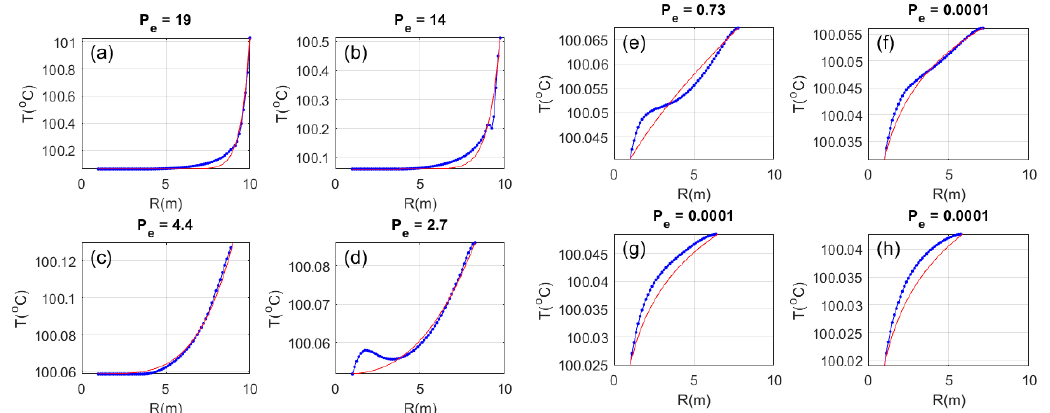
Figure 17. Following Figure 11, 2D analytic wellbore-centric radial temperature profiles (red traces) for given Peclet number superposed on 3D numerical model radial temperature distributions (blue dots) for 1 m radius wellbore embedded in 10-m radius crustal volume (Figure 14) with a 0.6 m fracture-connectivity structure. From upper left, plots ( a – h ) show 3D model radial temperature distributions fit to 2D steady-state radial temperature distributions (5) governed by numbers P e = r 0 φ v 0 /D. The Peclet number for the fracture-connectivity horizon in plot ( a ) is 19. Stepping away from the horizon in 1.5 m intervals, Peclet numbers decline for plots ( b – d ) indicating fluid advection P e = 14, 4.4 and 2.7 and plots ( e – h ) with P e = 0.7 to 0 indicating thermal